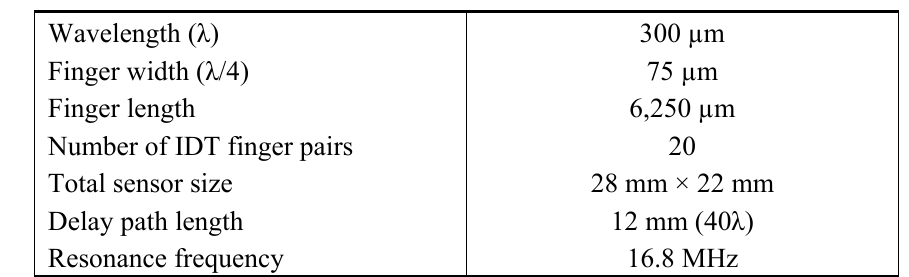
Table 2. Sensor design